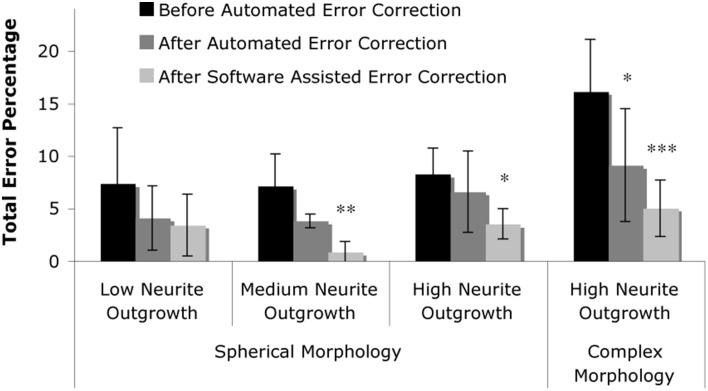
Summary of results. The total error percentage, defined as the number of false positives counts plus the number of false negative counts in comparison to the actual number of cells, was calculated for levels one through three (spherical morphology with increasing levels of neurite outgrowth) and level four (complex morphology with high neurite outgrowth). Two-Way repeated measures ANOVA revealed that the total error was reduced by the presence of automated error correction (p < 0.001), and was further reduced by correction of software-identified probable error points (p < 0.05). Tukey's post-hoc pair-wise comparisons revealed significant error reduction within levels two through four; asterisks denote significant reduction in total error percentage vs. “Before Automated Error Correction” within each level (*p < 0.05; **p < 0.01; ***p < 0.001).